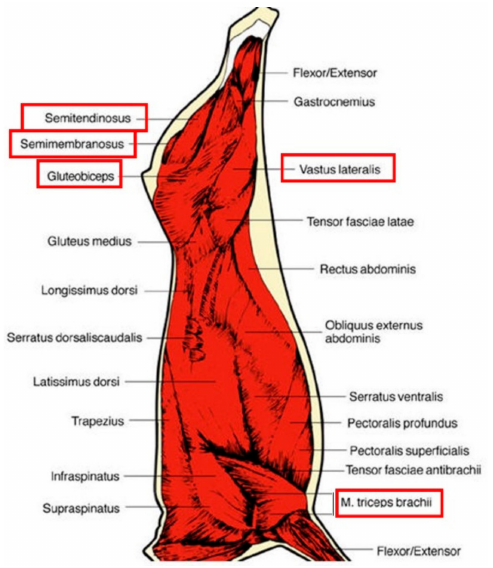
Figure 1. Location of the 5 muscles studied, the names of which are framed in